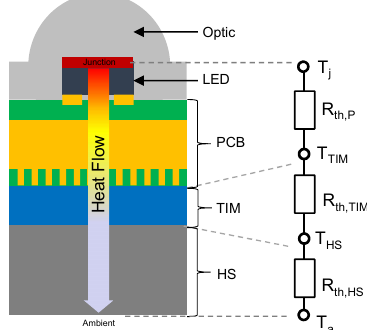
Figure 1. Structure of a typical LED system and its main thermal resistances determining the heat flow from junction to